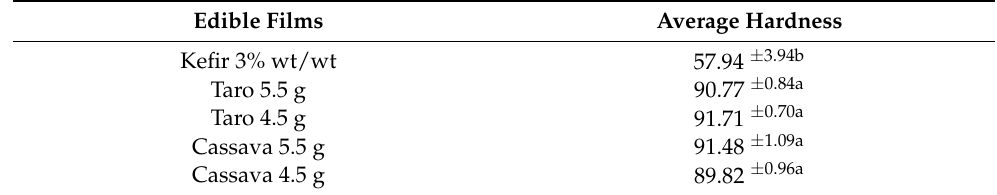
Table 9. Hardness of edible films obtained.